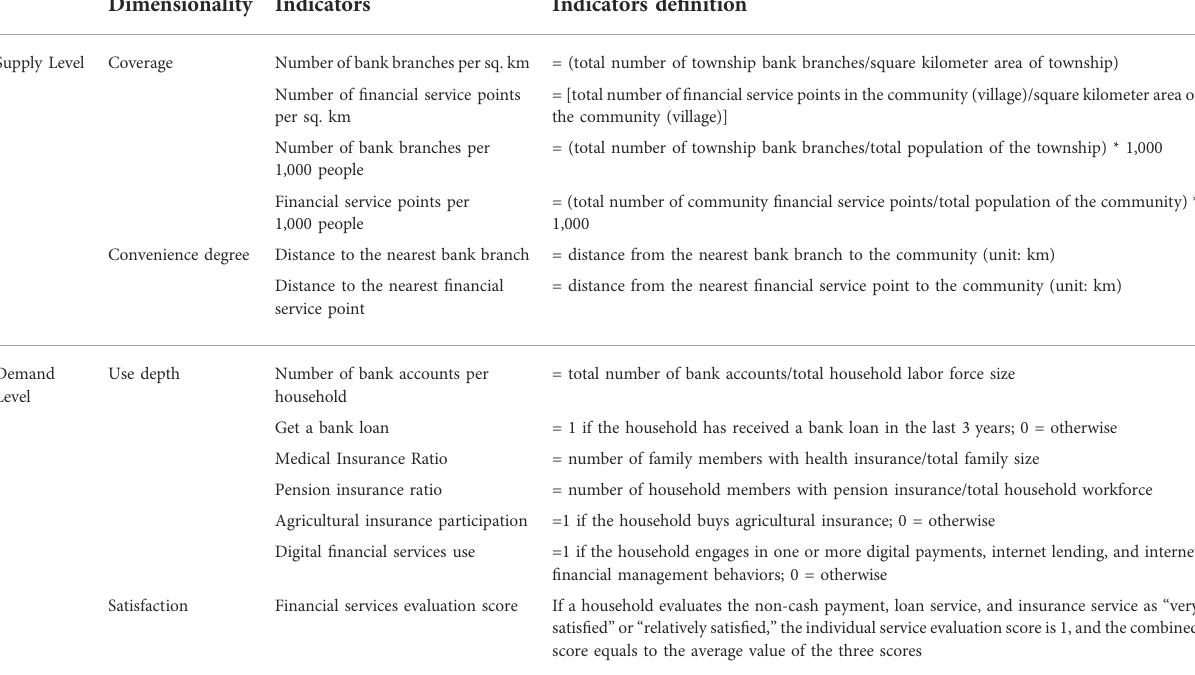
TABLE 1 Index system of rural household fi nancial inclusion. Dimensionality